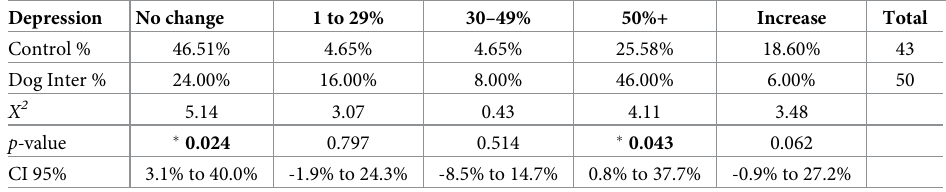
Table 12. Proportion of participants in each change response category and chi-square statistics.